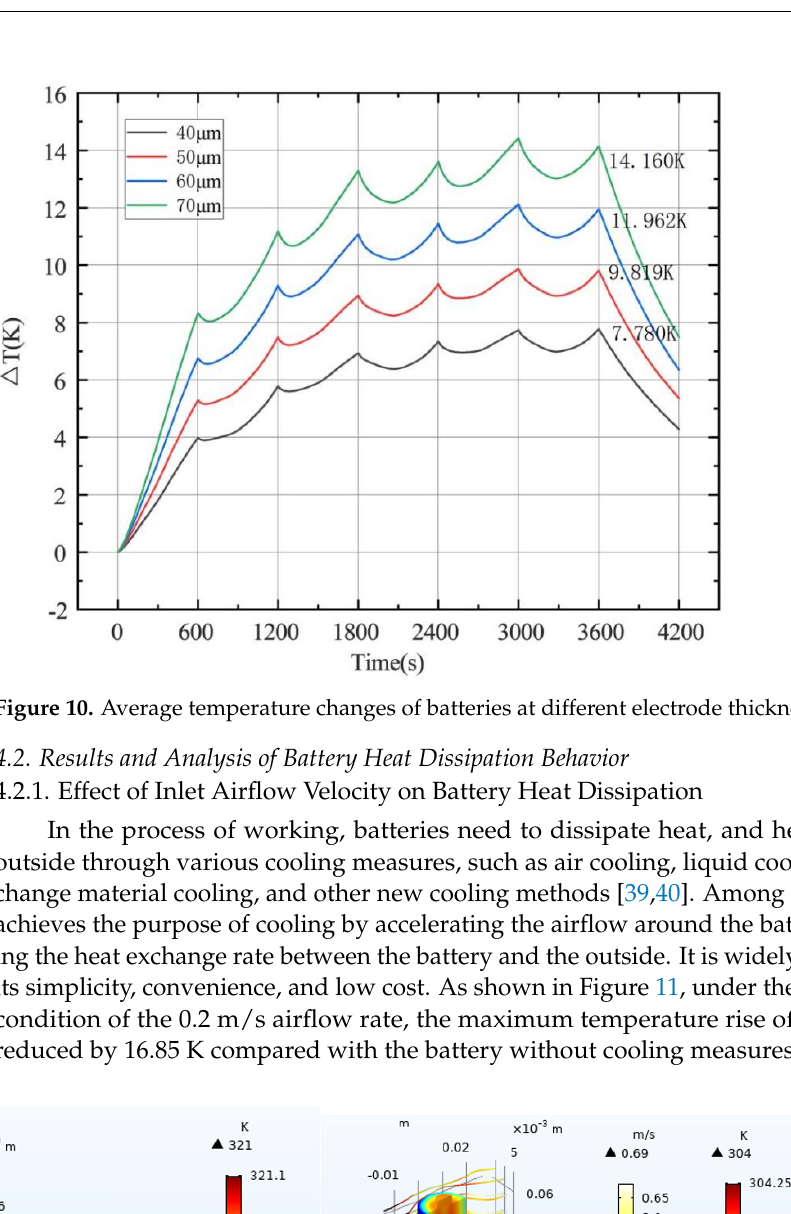
Figure 10. Average temperature changes of batteries at different electrode thickness.